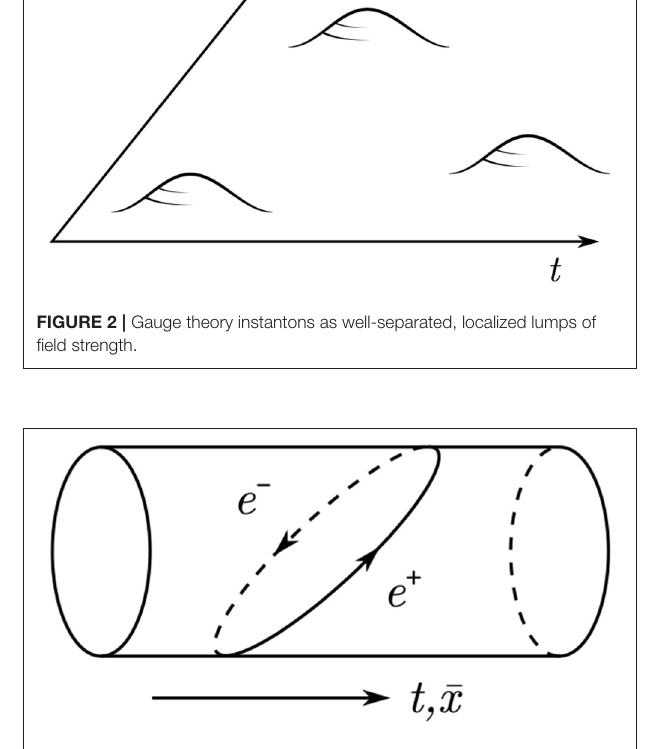
FIGURE 3 | Euclidean brane instanton as particle-antiparticle fluctuation wrapping the compact space.